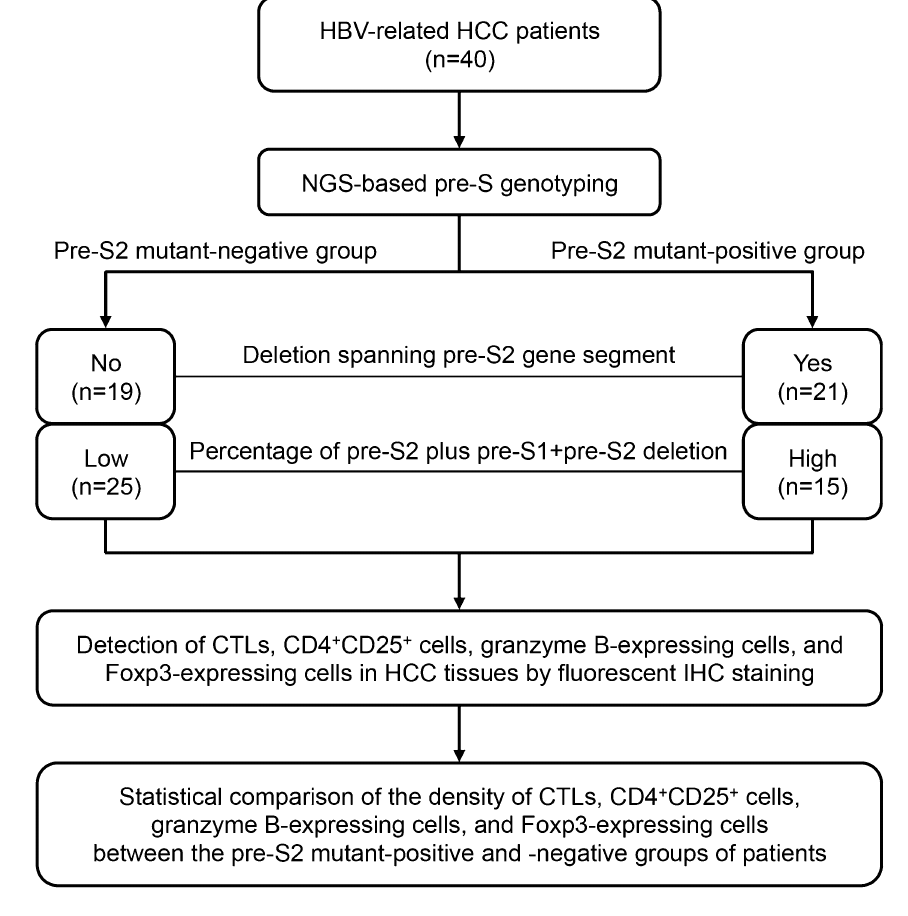
Figure 1. Flowchart for patient classification and quantitative analysis of CTLs, CD4 + CD25 + cells, granzyme B-expressing cells, and Foxp3-expressing cells in HCC tissues in this study. By NGS-based pre-S genotyping, HBV-related HCC patients were divided into two groups, the pre-S2 mutant-positive and -negative groups, according to either the presence of deletion spanning pre-S2 gene segment or the percentage of pre-S2 plus pre-S1 + pre-S2 deletion. By fluorescent IHC staining, CTLs, CD4 + CD25 + cells, granzyme B-expressing cells, and Foxp3-expressing cells in HCC tissues were detected and quantified as the density of CTLs, CD4 + CD25 + cells, granzyme B-expressing cells, and Foxp3-expressing cells for comparative analysis between the two groups of